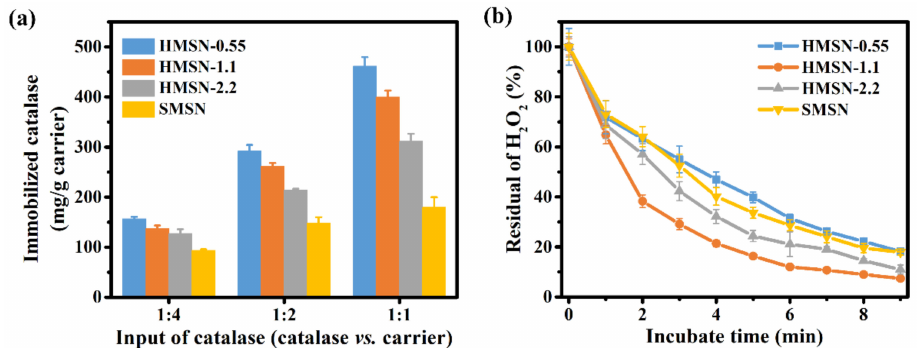
Figure 7. ( a ) Amount of catalase immobilized on various mesoporous silica materials with a cata- lase/carrier ratio of 1:4, 1:2, and 1:1 in the initial incubation solution. Concentration of the carriers was fixed at 0.5 mg g − 1 . ( b ) Comparison of catalase activity in H 2 O 2 decomposition for the enzymes immobilized in HMSNs and